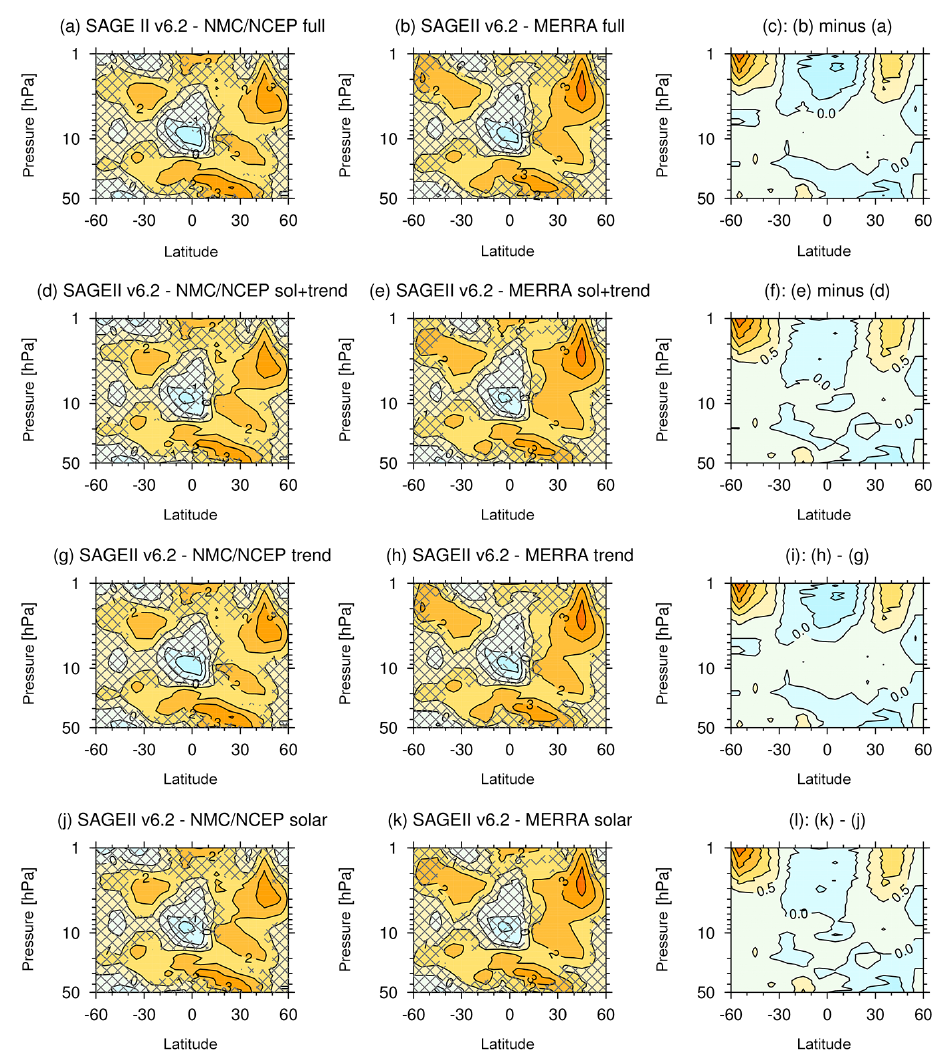
Figure 8. The percent (%) annual solar-ozone response (SOR) (per 130SFU) in SAGE II v6.2 data converted from number densities to mixing ratios for the period 1985–2003 using the method described in Sect. 4.1.2. The conversion is first conducted using full time series of monthly (a) NMC/NCEP and (b) MERRA-1 temperatures. Panel (c) shows (b) minus (a) . A comparison of panels (a–c) with Fig. 4a–c demonstrates the performance of the post hoc conversion. (d–f) As in panels (a–c) but with the number density to mixing ratio conversion performed using a monthly temperature climatology from MERRA-1 added to a linear trend and solar signal in stratospheric temperatures extracted from (d) NMC/NCEP and (e) MERRA-1. The remaining rows show the same as panels (d–f) but with the conversion performed with the (g–i) linear trend or (j–l) solar cycle temperature terms alone. The shading is as is Fig. 4. The contour interval is 1% in the left and middle columns and 0.5% in the right-hand